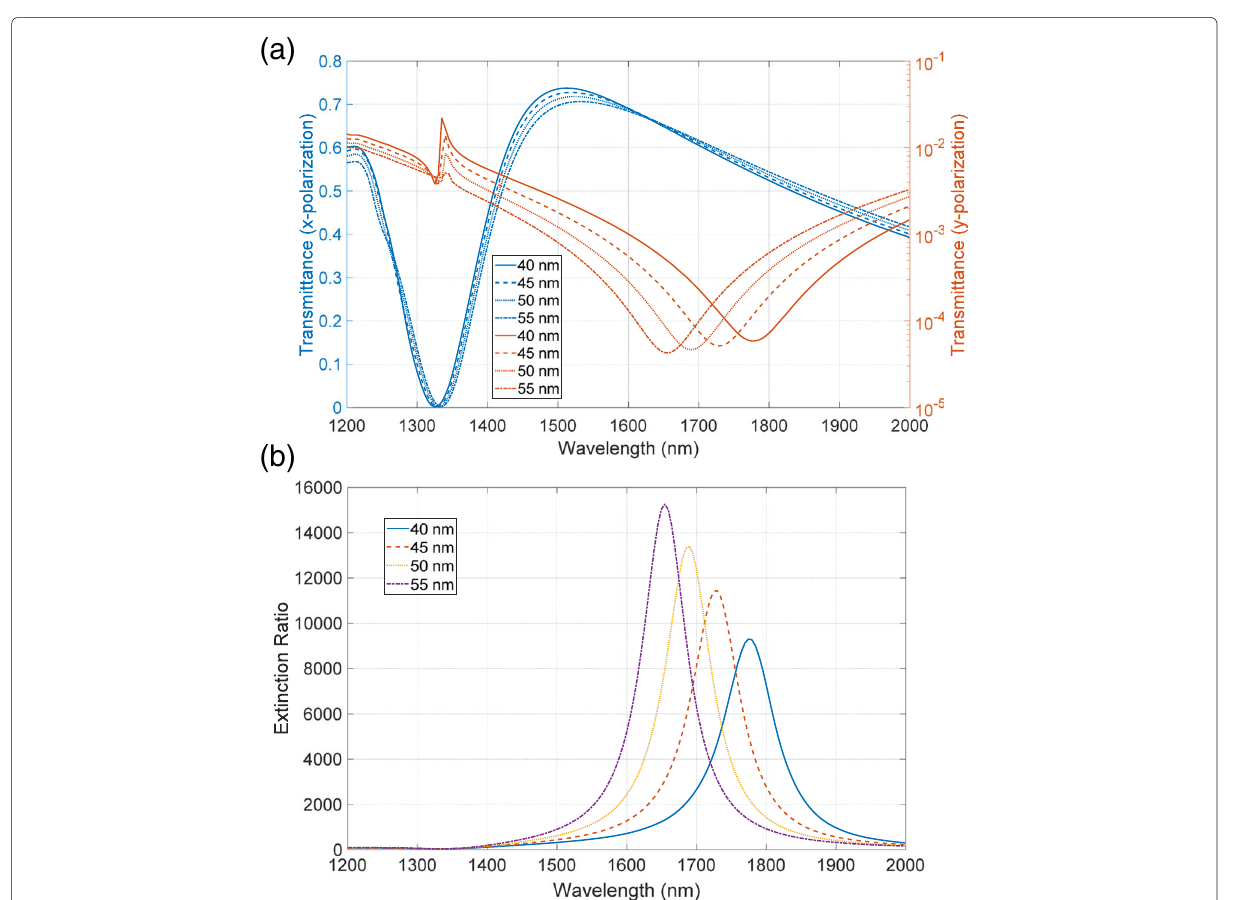
Fig. 9 a Transmittance and b extinction ratio spectra of the first model shown in Fig. 8. The base thickness of the bottom metallic layer is varied from 40 to 55 nm with a step of 5 nm increase in the loss. These features of the drastic degrada- metallic loss. As a result, the contribution from the peak tion and the blue-shift agree well with the experimentally value of the high transmittance to the extinction ratio observed features. The origin of this blue-shift is eluci- dated as follows. The dip value of the low transmittance becomes increasingly shallow with the increase in the